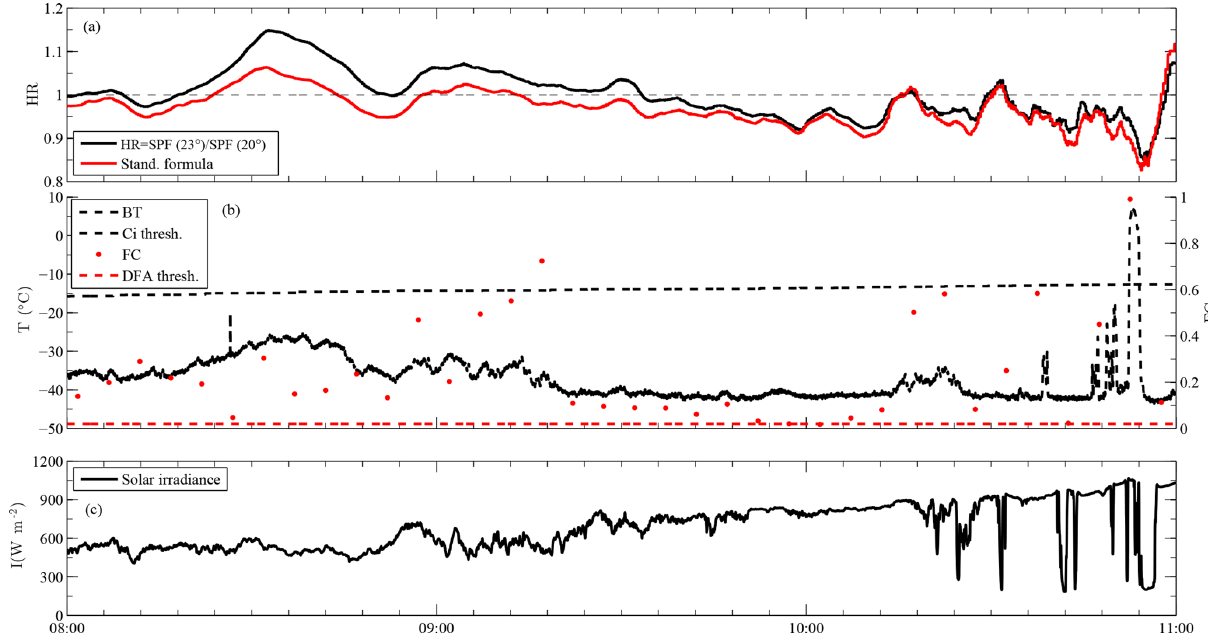
Figure 11. Time series from 6 July 2016 between 08:00 and 11:00. (a) HR (halo ratio), black line – new definition, red line – standard formula – (see text). (b) BT (brightness temperature) – black line, FC (fluctuation coefficient) – red dot, DFA (detrended fluctuation analysis) threshold – red dashed line, Ci (cirrus) threshold – black dashed line. (c) Solar